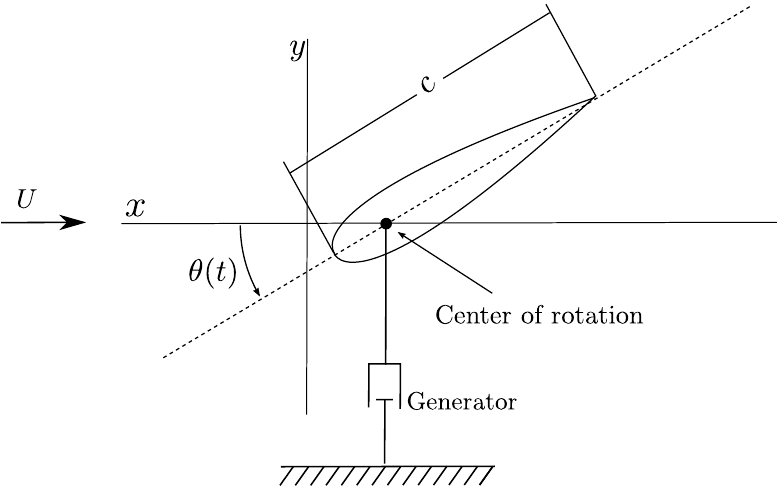
Figure 1. Scheme of the active model